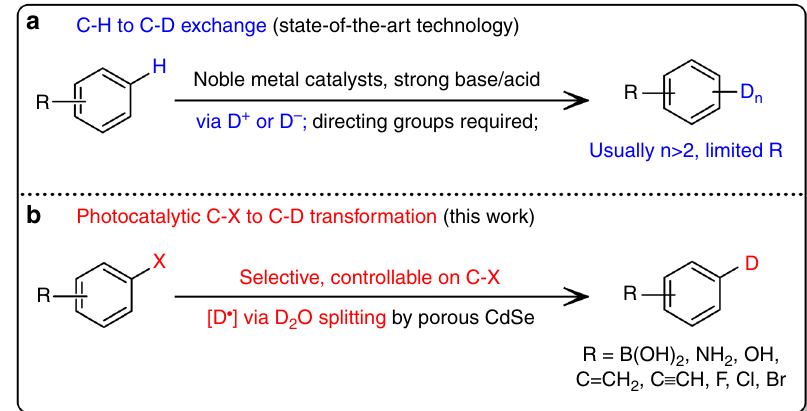
Fig. 1 Proposed deuteration strategy. a State-of-the-art C – H to C – D exchange; b photocatalytic C – X to C – D transformation in this